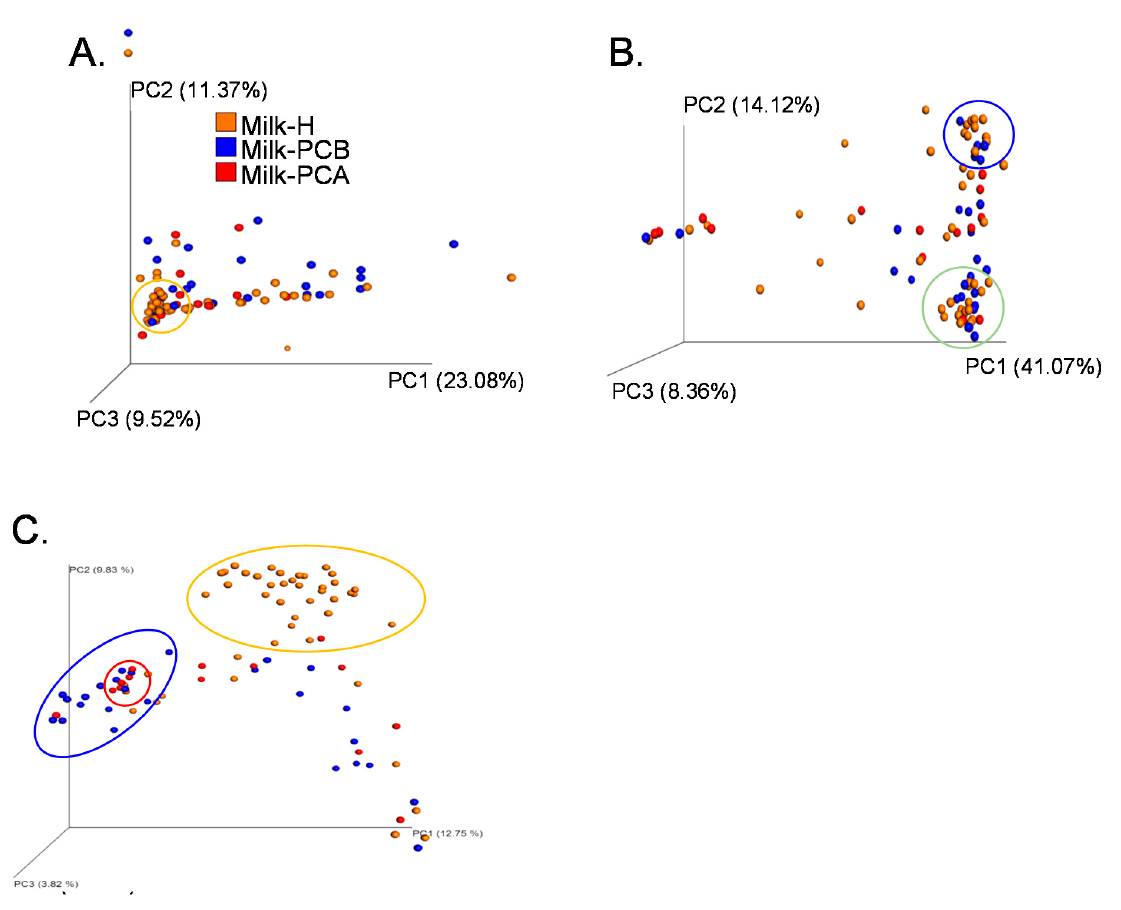
Figure 5. Beta diversity analysis of the milk microbiota between two “doing-the-month” and one “non-doing-the-month” milk groups. Principal component analysis ( A ), principal coordinate analysis based on the weighted UniFrac metric distance ( B ) and unweighted UniFrac metric distance ( C ) of three milk groups are shown. The keys for milk-H, milk-PCA, and milk-PCB are described in Table 1. Briefly, milk-H ( n = 46): “non-doing-the-month” milk group; milk-PCA ( n = 14) and milk-PCB ( n = 27): “doing-the-month” milk group. The orange circle in ( A ) indicates the dimensional area for the clustered milk samples. The green or blue circle in ( B ) indicates the two-dimensional area for the clustered milk samples. The orange, blue, or red circle in ( C ) indicates the three-dimensional area for the relatively aggregated milk samples.